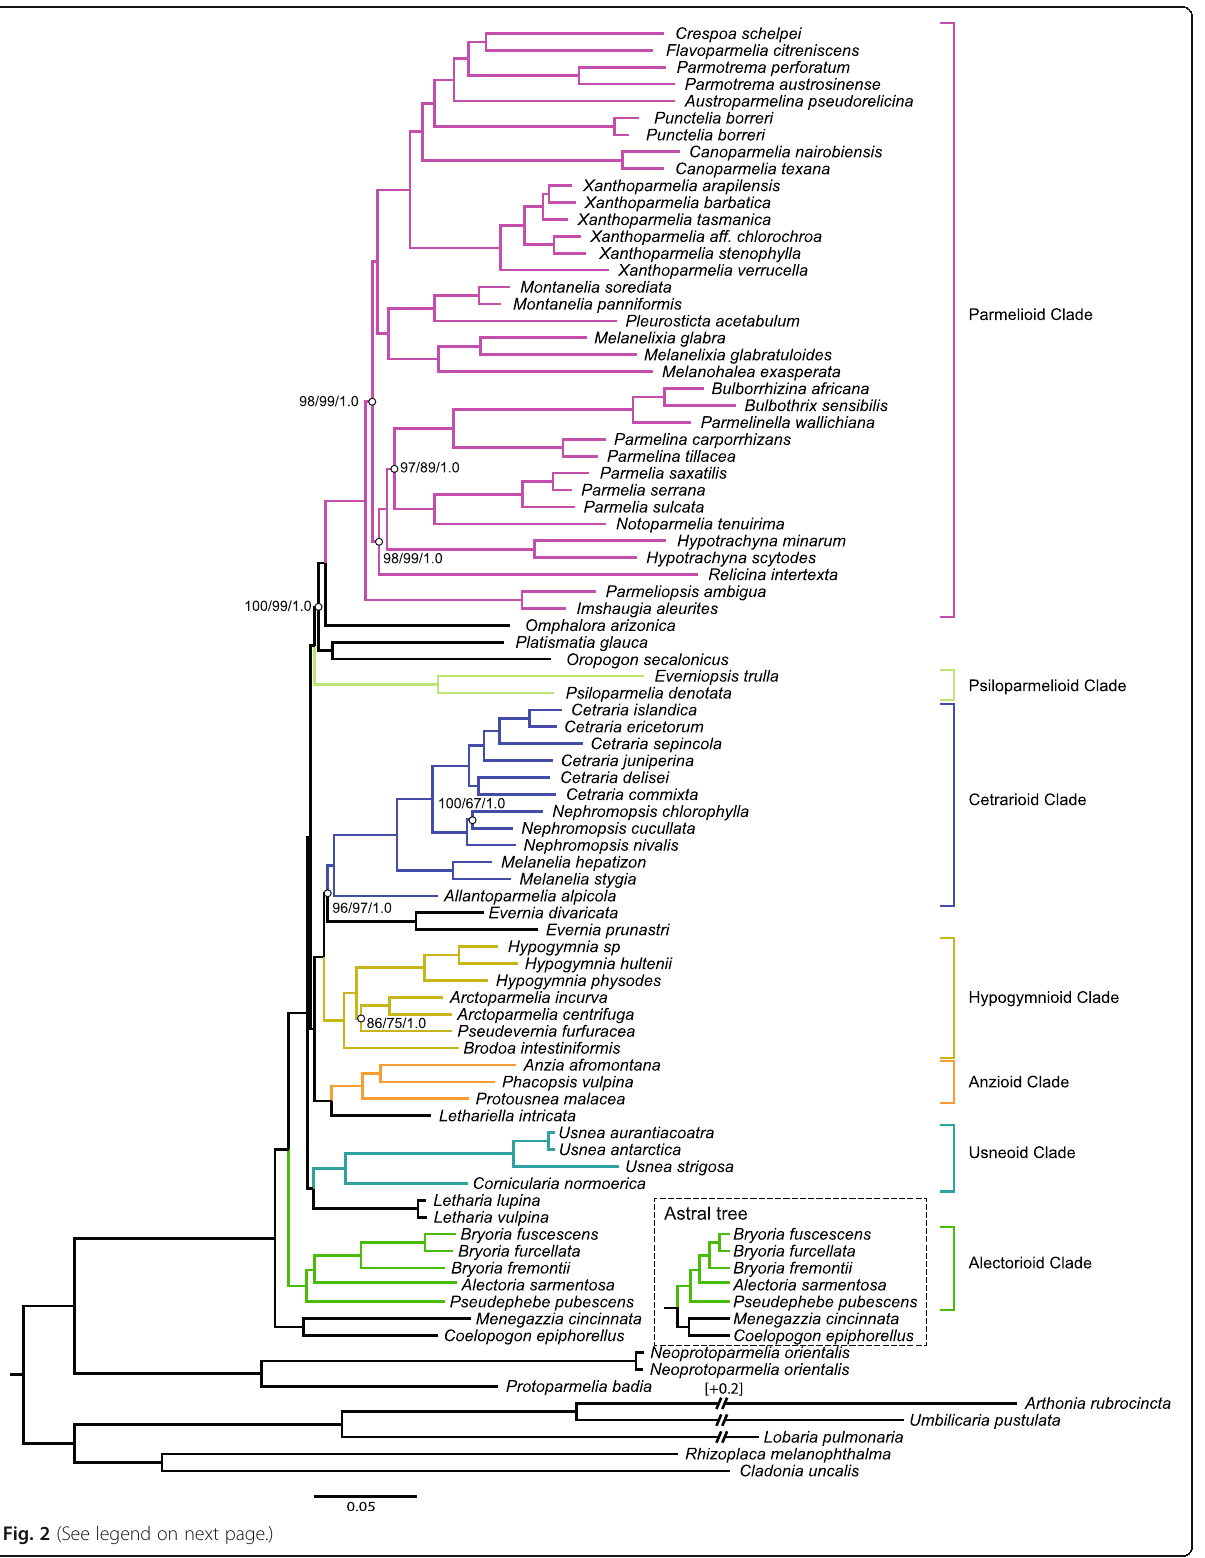
Fig. 2 (See legend on next